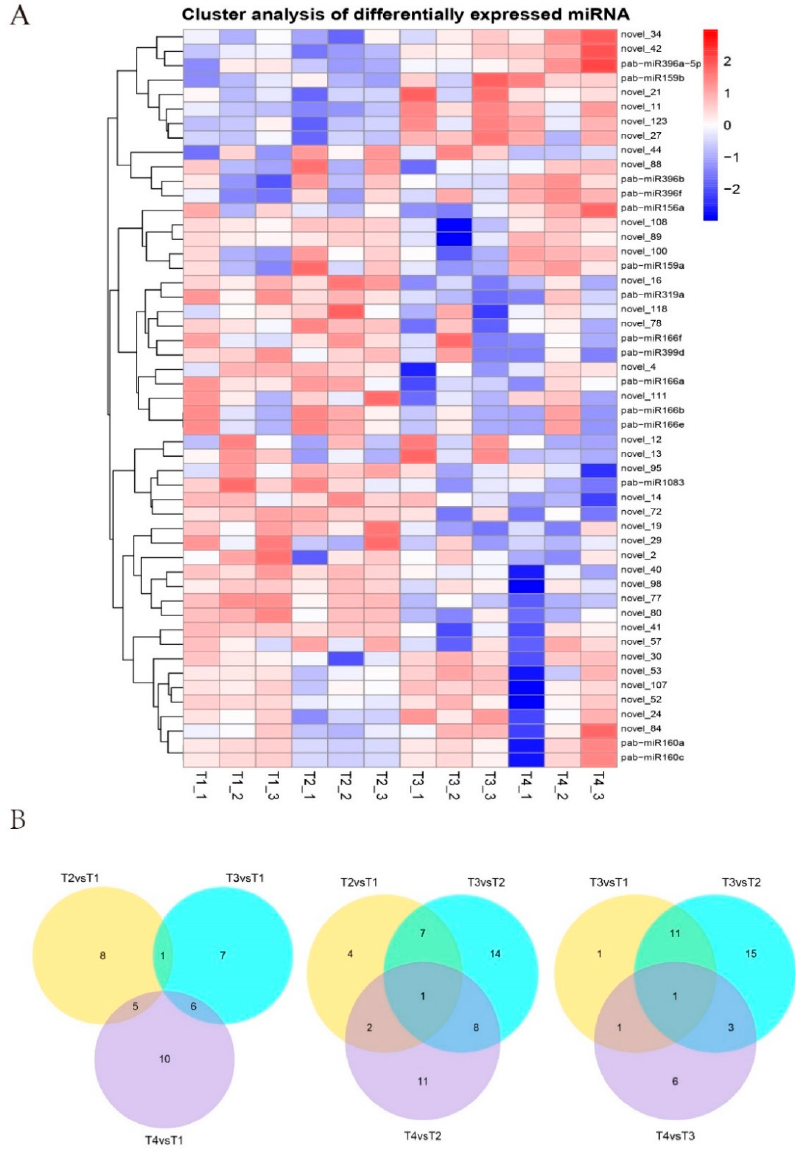
Figure 1. Expression analysis of miRNAs. ( A ) Cluster analysis of relative differential expression of 52 miRNAs. The bar represents the scale of the expression abundance for each miRNA (log 10 (TPM + 1)), where, relative to control levels, red represents miRNA with high expression and blue represents miRNA with low expression; T1-1-T1-3 indicated three biological replicates of T1 sample (control), T2-1-T2-3 indicated three biological replicates of T2 sample (100 mM NaCl, 1 h), T3-1-T3-3 indicated three biological replicates of T3 sample (200 mM NaCl, 1 h), T4-1-T4-3 indicated three biological replicates of T4 sample (200 mM NaCl, 24 h). ( B ) Differentially expressed miRNAs among different salt treatments presented by VENN analysis.